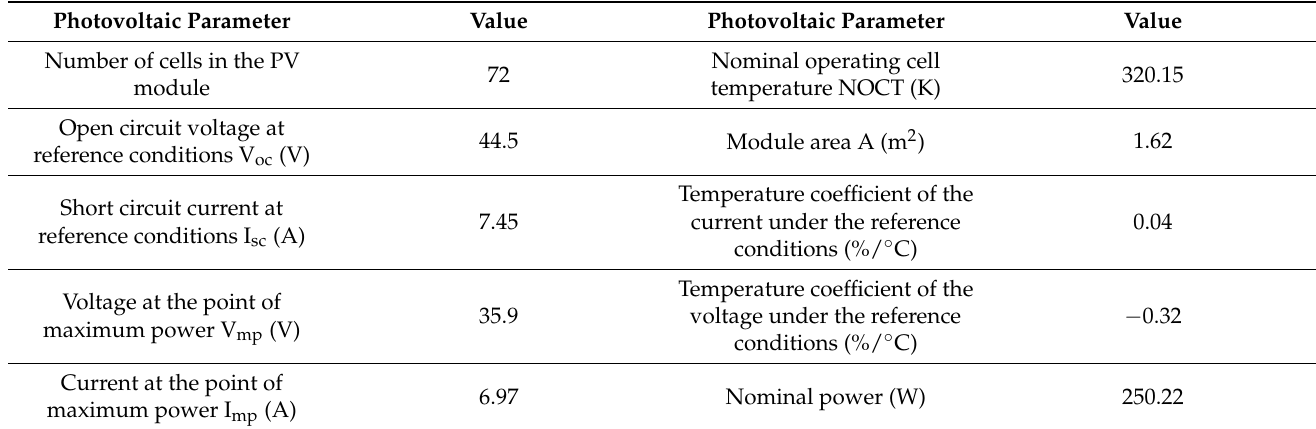
Table 1. Electrical characteristics of Jakson 250 photovoltaic module.